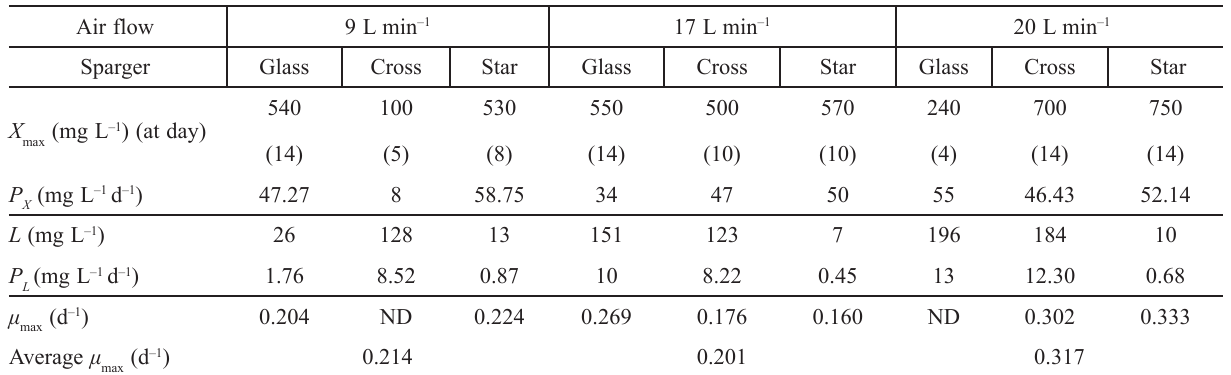
Table 3 – Summary of the Chlorella culture assessments. Effect of sparger type and air flow rate. Air